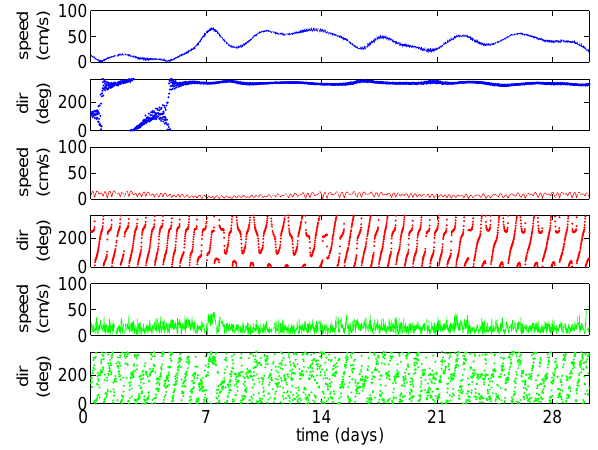
Fig. 9. Speed (cms − 1 ) and direction (degrees) of the mean-residual (blue), tidal (red), and surge (green) components at location FB, 524m depth (from 14 November 1997 to 14 December